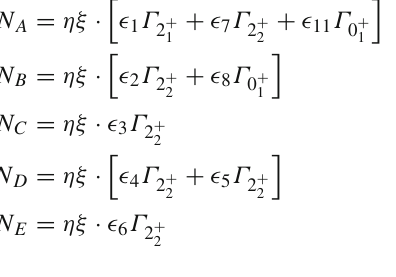
the mass considered for the analysis is 8.74kg (3.41 × 10 25 nuclei of 82 Se).